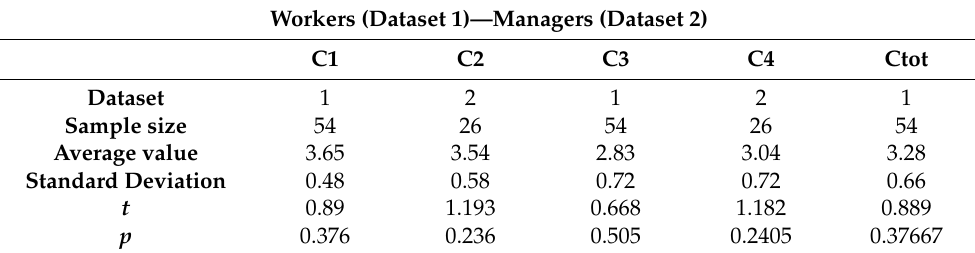
Table 11. Results of the t -test analyses related to the correlation worker–manager in the COVID-19 questionnaire 1 .